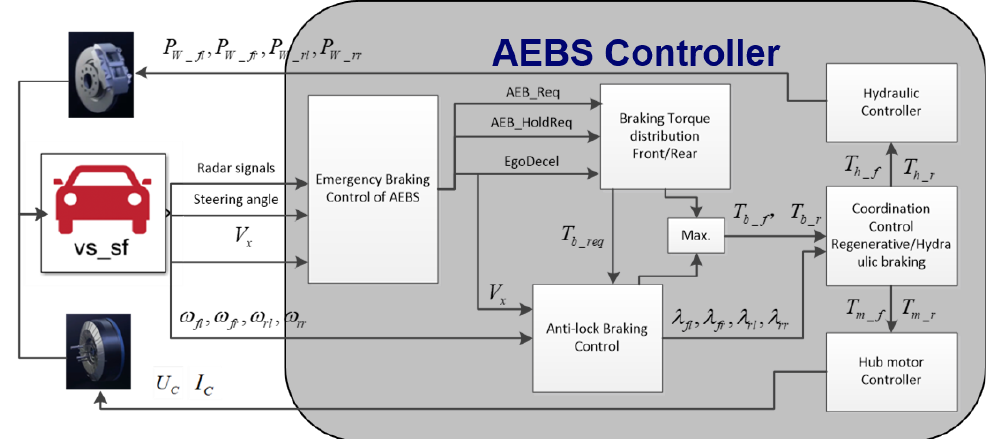
Figure 4. Architecture of the AEBS controller.